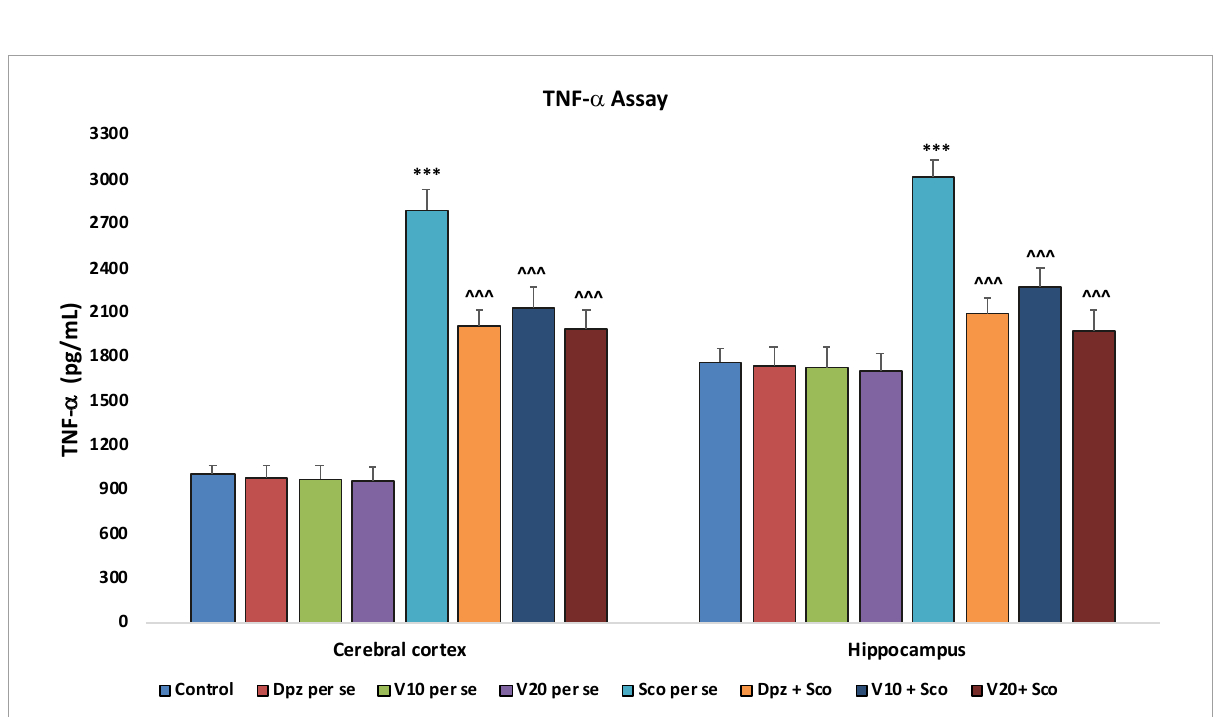
FIGURE23 Effect of vanillin and other treatments on TNF- α concentrations. Data are expressed as mean ± SEM “***” denotes P < 0.001 with respect to the control group. “ ∧∧∧ ” denotes P < 0.001 with respect to the negative control (Sco per se )